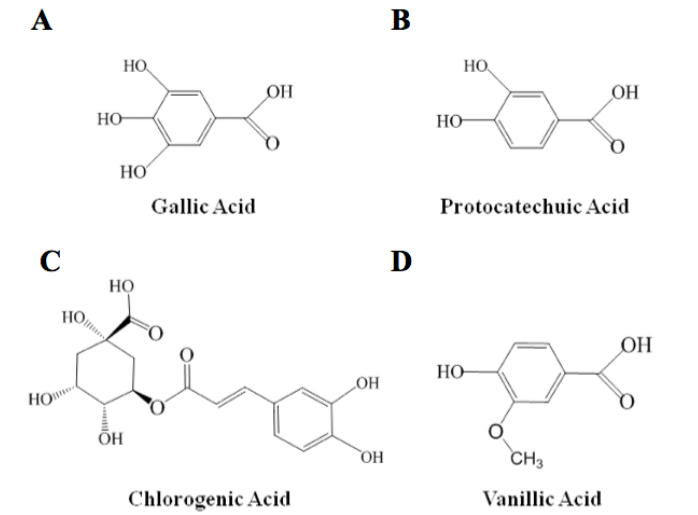
Figure 2. Chemical structure of the compounds studied in this